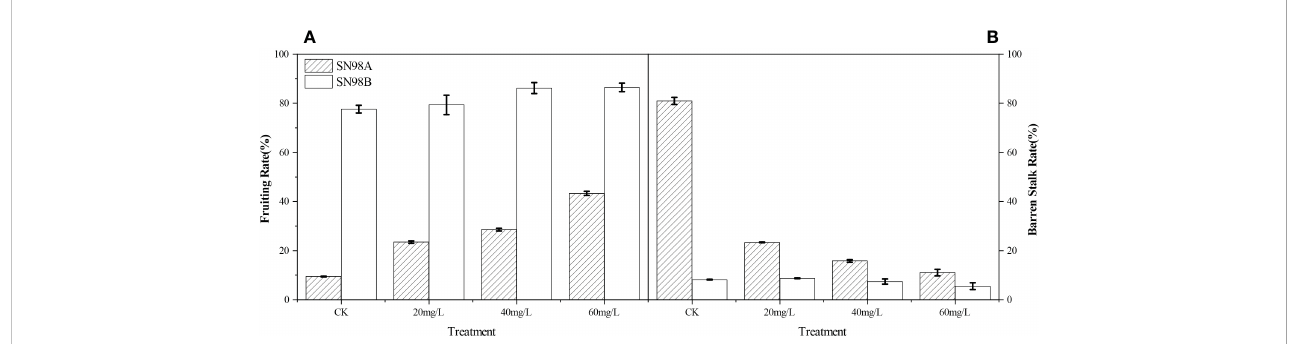
FIGURE 1 Effects of exogenous GA 3 on seed setting rate and hollow stalk rate in different light-sensitive inbred maize lines under low light-stress. (A) Seed setting rates in different light-sensitive inbred maize lines sprayed with different concentrations of GA 3 and water. (B) Hollow stalk rates in different light-sensitive inbred maize lines sprayed with different concentrations of GA 3 and water. CK is the control water spraying treatment under shade. The numbers 20, 40, and 60 denote GA 3 concentrations of 20 mg L – 1 , 40 mg L – 1 , and 60 mg L -1 , respectively. SN98A is the shade intolerant line and SN98B is the shade tolerant line. Values are expressed as mean ± SD of three replicates. Lower-case letters indicate the mean difference of different treatments in the same period, which is statistically signi fi cant